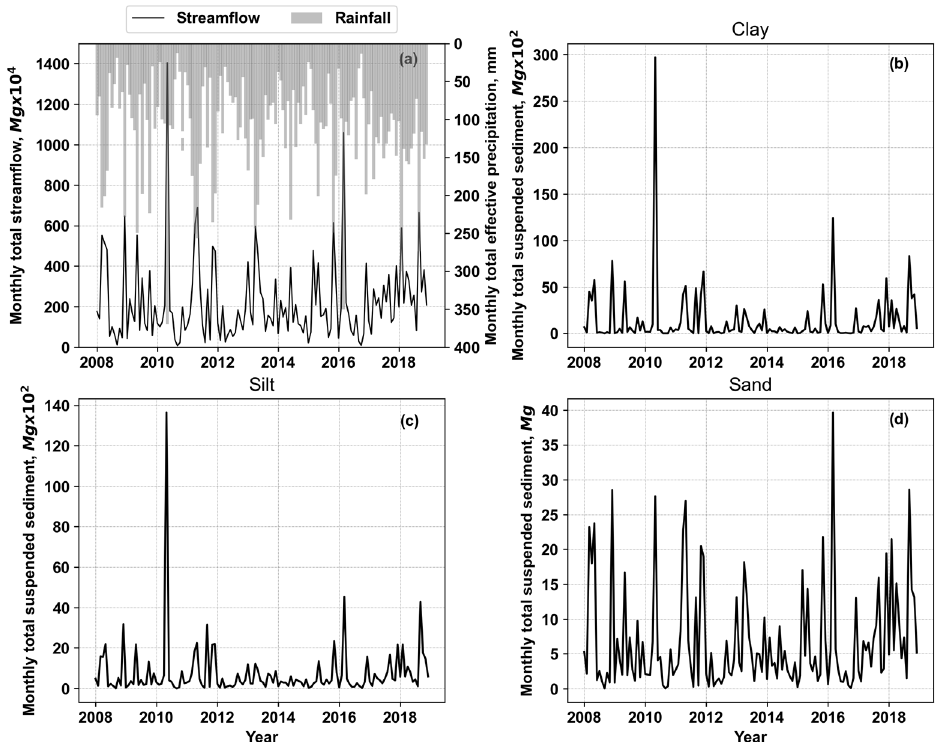
Figure 10. Streamflow ( a ) and suspended sediment load for silt ( b ), clay ( c ), and sand ( d ) sizes at the watershed outlet as simulated by the AnnAGNPS model representing existing conditions.